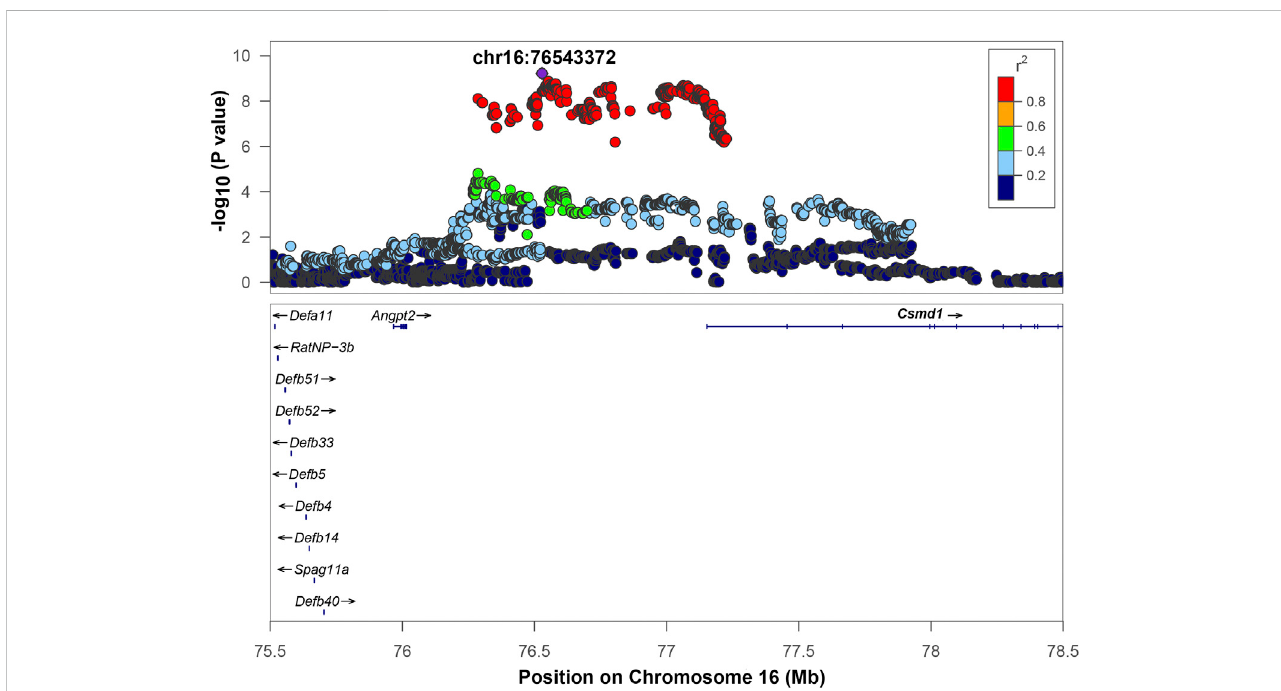
FIGURE 5 Regional association plot for QTL on chromosome 16. The x -axis shows the chromosomal position. The SNP with the lowest p -value ( “ top SNP ” ) is showninpurple,anditschromosomalpositionisindicatedontheplot.Colorofthedotsindicatesleveloflinkagedisequilibrium(LD)ofeachSNPwiththetop SNP, as measured bycorrelation. Thebottom panel indicates thegenes intheregion, as annotated bythe NCBIReference Sequence Database(O ’ Learyet al., 2016). *Angpt2 gene lies outside of the interval of high LD (r 2 > 0.6). Gene(s) that are bolded ( Csmd1 ) are located in the interval of high LD of the top SNP based on an r 2 > 0.6